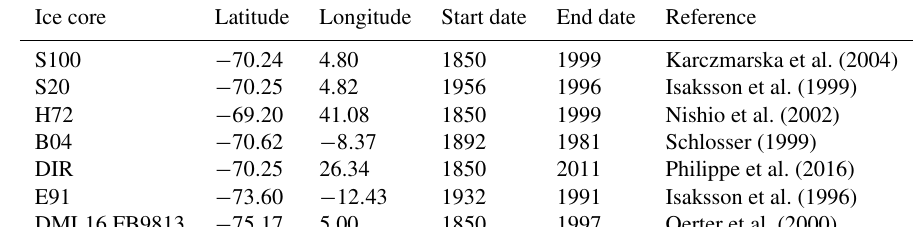
Table 1. Ice cores drilled over Dronning Maud Land used for comparison, extracted from Thomas et al. (2017).